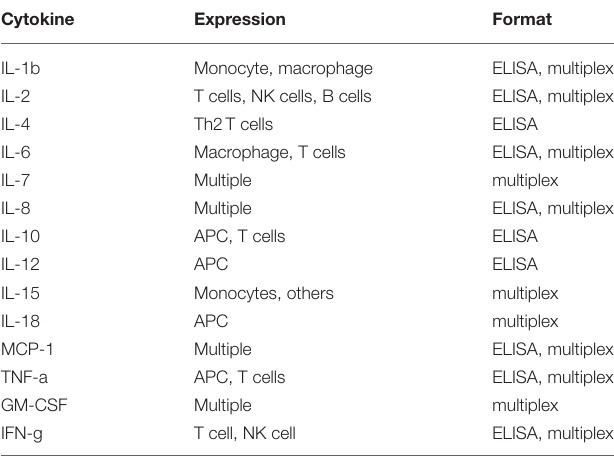
TABLE 3 | Cytokine reagents for